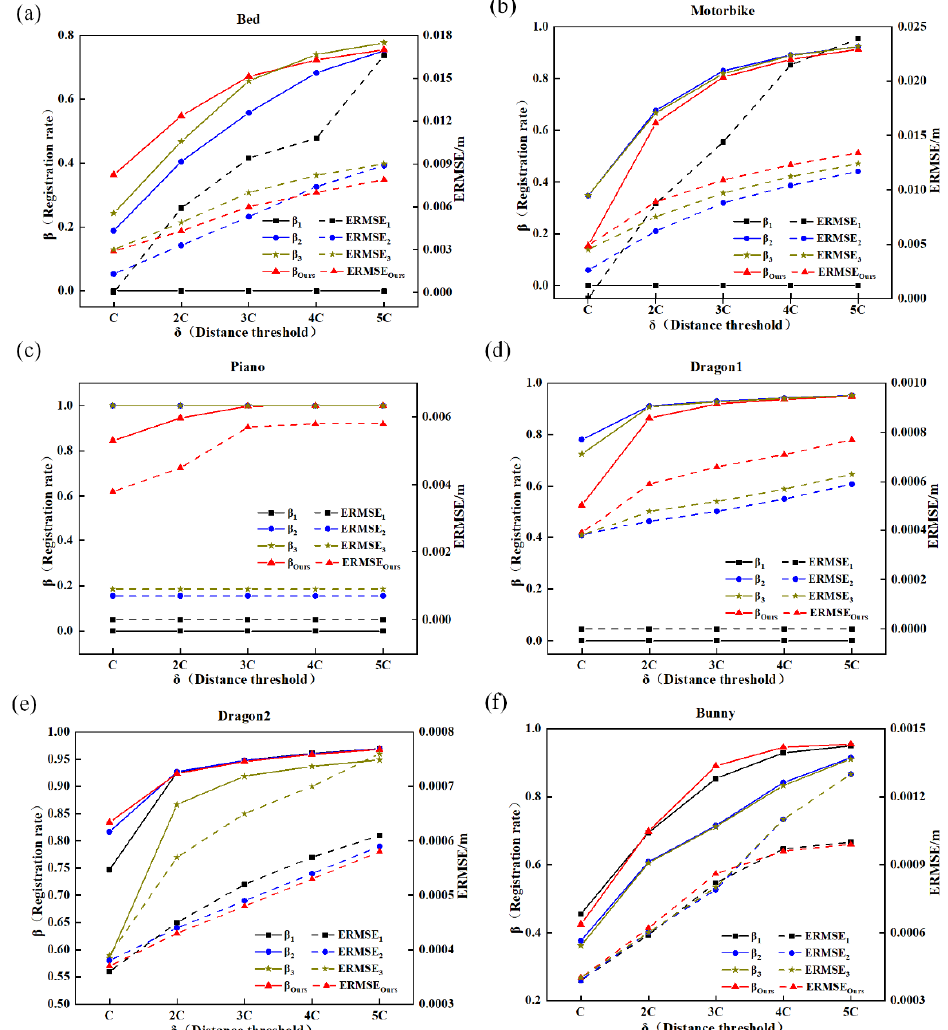
Figure 10. Analysis of registration resultsby iterative closest point (ICP), sample consensus initial alignment (SAC-IA+ICP), 3D histograms of point distributions ICP (3DHoPD+ICP) and our method. (a) Bed, (b) Motorbike, (c) Piano, (d) Dragon1, (e) Dragon2, (f) Bunny.